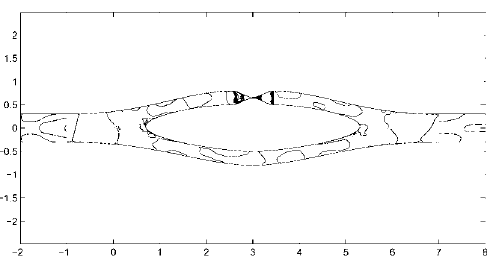
Figure 7. The contour of the error in the reduced basis pressure solution p N when N 1 (cid:1) 15 and N 2 (cid:1)